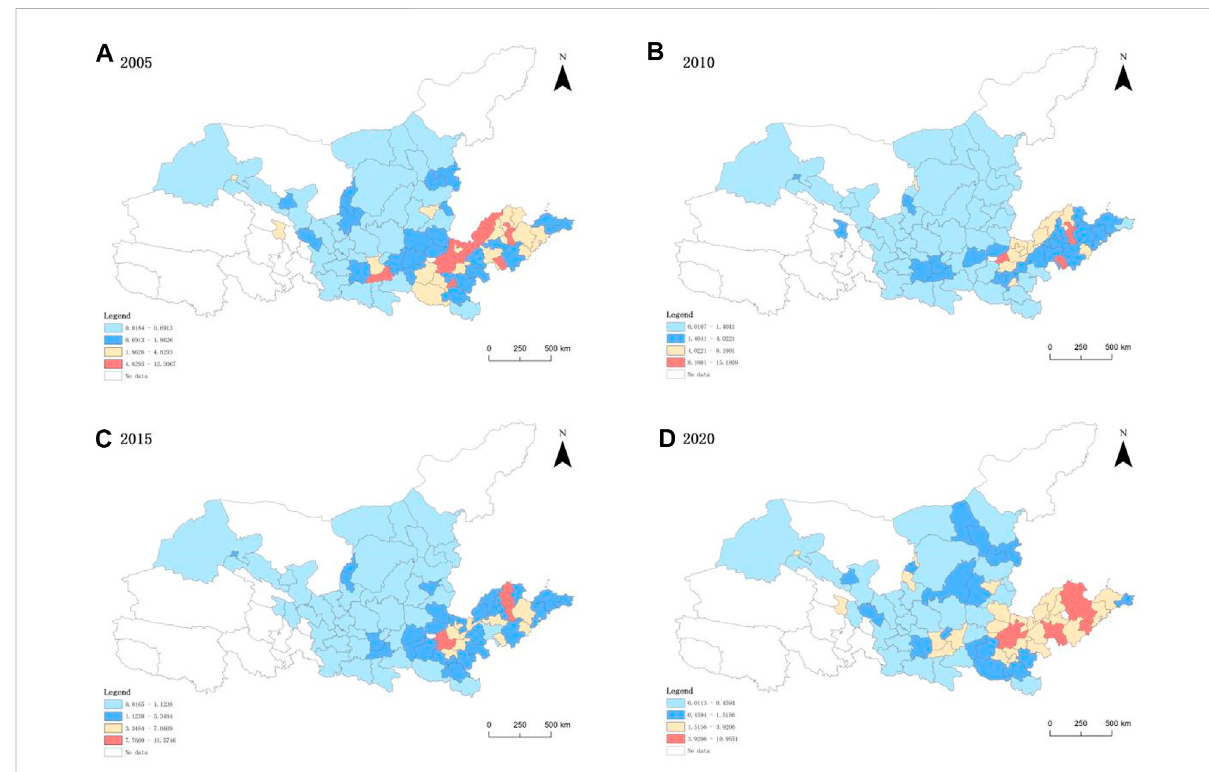
FIGURE 3 Spatial pattern of industrial wastewater discharge agglomeration in the Yellow River Basin in 2005, 2010, 2015,